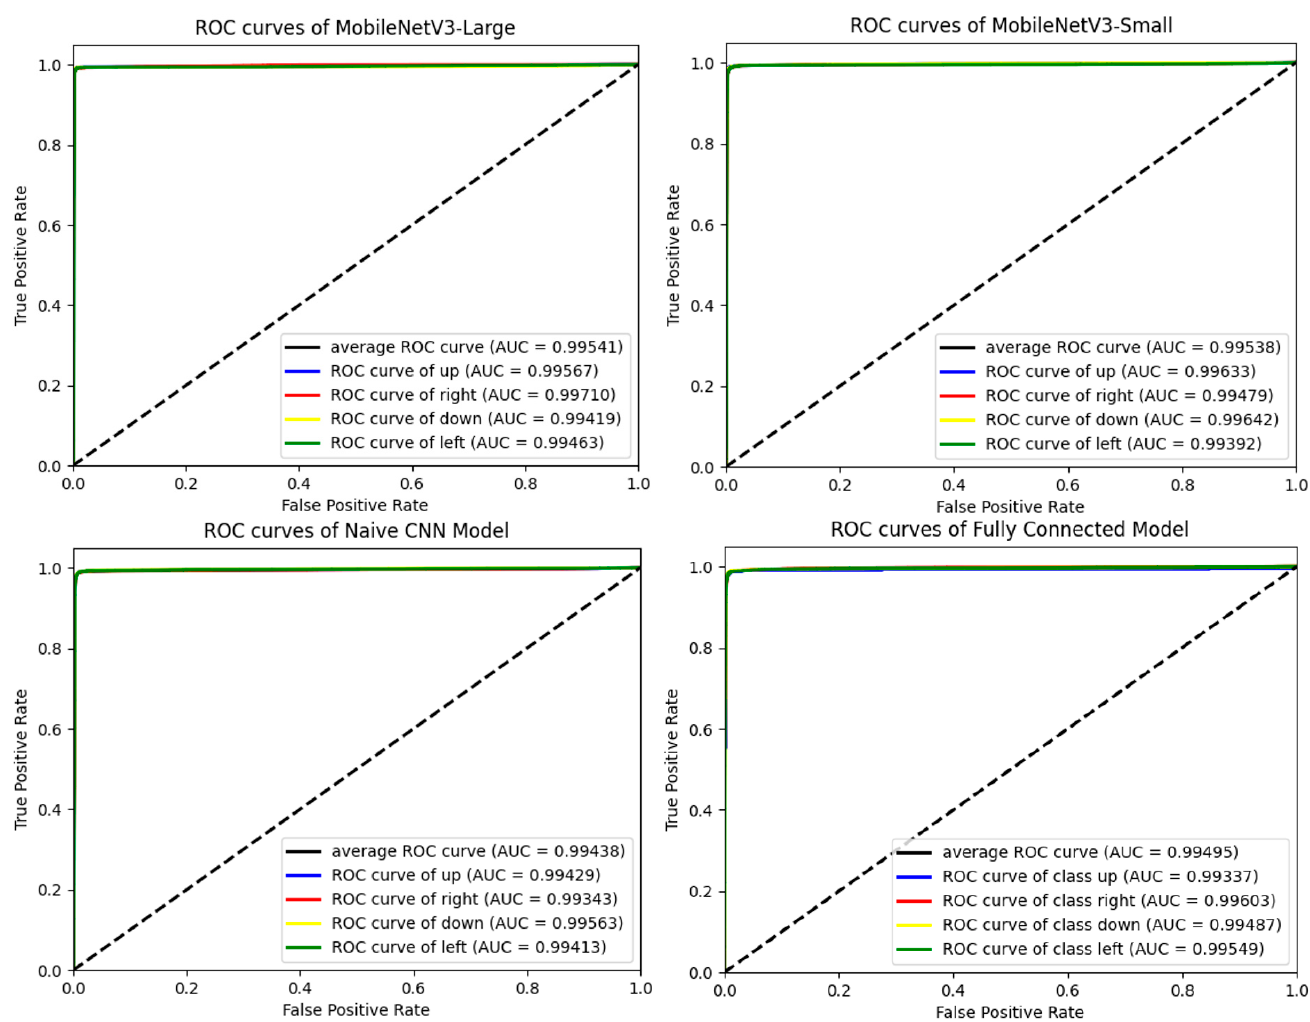
Figure 19. ROC and AUC for models with recognition rates over 98%. Table 5. Inference speed of the model on OrangePi 3